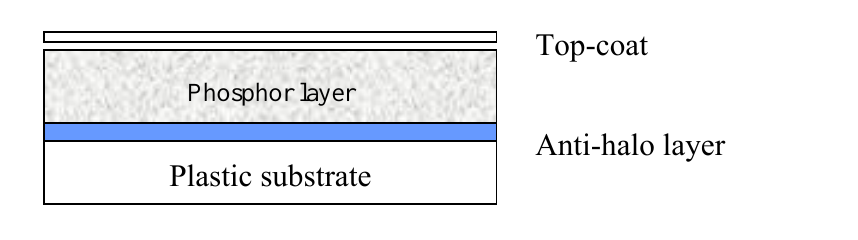
Figure 7. Drawing of typical PIP